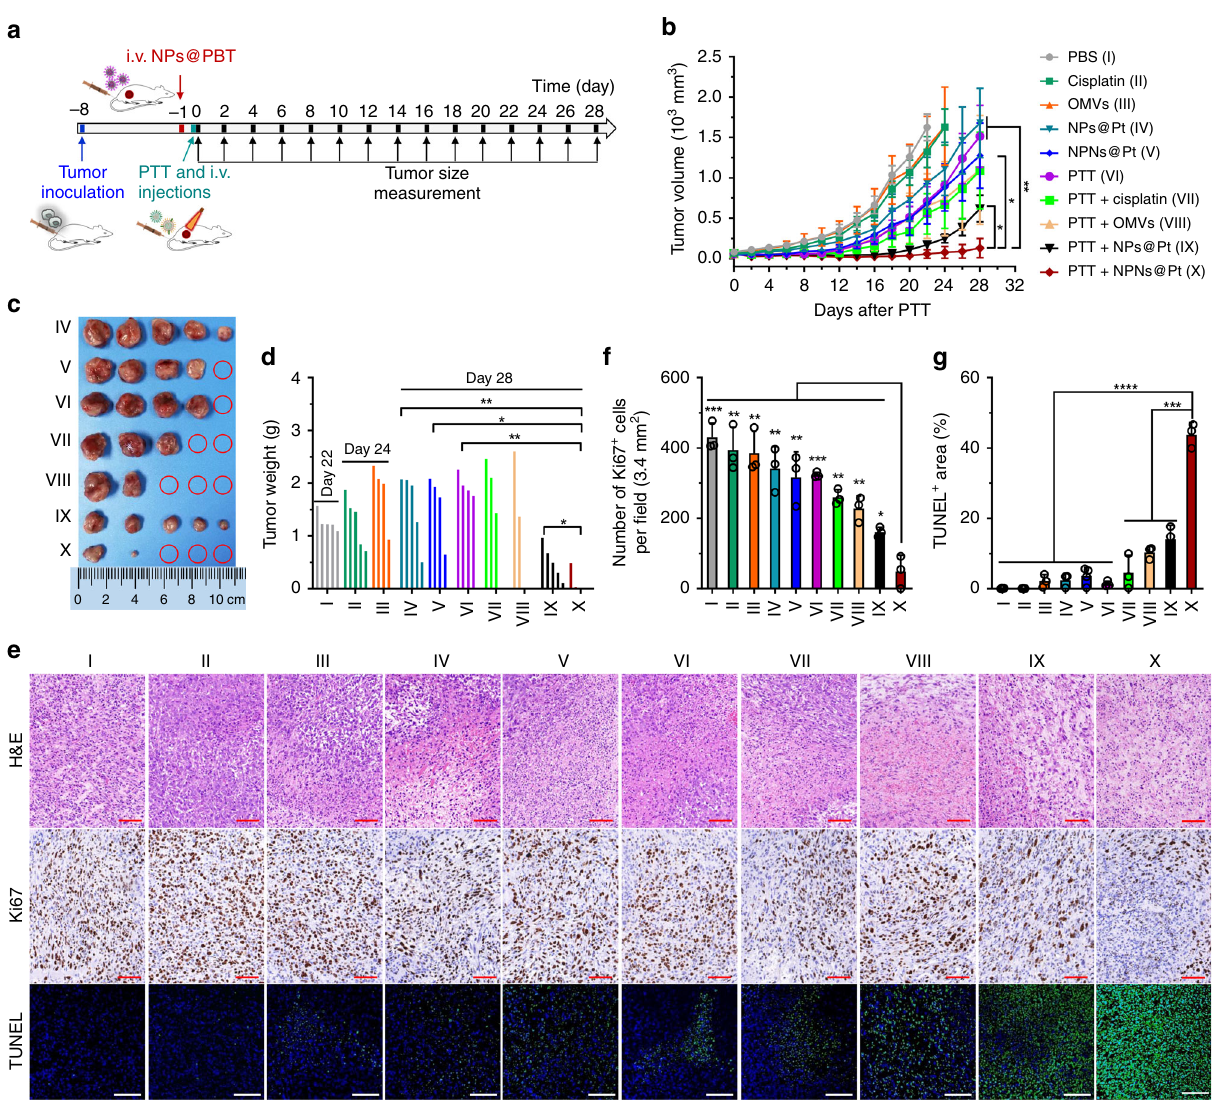
Fig. 7 PTT in combination with NPNs@Pt enhanced anti-tumor effect. a Work fl ow for treatment of EMT6-bearing mice using PTT-based neutrophil- mediated NPNs@Pt delivery system. On day -1 (de fi ned as the 7th day after tumor inoculation), mice were i.v . injected with NPs@PBT. On day 0, the mice were received PTT treatment and were administrated with PBS, cisplatin, OMVs, NPs@Pt, or NPNs@Pt after 30 min. Tumor volumes were measured every two days from day 0 to day 28. b Tumor growth curves during the treatments. c Photos and d weight of the tumors collected on day 28. n = 5 mice per group for b – d . e Representative images of H&E, Ki67, and TUNEL staining of tumor tissues obtained on day 3 after the PTT treatment. Scale bars, 100 μ m. f Number of Ki67 + cells per fi eld (3.4 mm 2 ) in the tumor slices in e . Signi fi cant analyses were performed compared with Group X. n = 3 per group. g Percentage of TUNEL + area in the tumor slices in panel e . n = 4 for group I, II, V, and n = 3 for all other groups. Data are shown as mean ± SEM ( b ) or mean ± SD ( f , g ), and analyzed by unpaired two-tailed Student ’ s t -test. * P < 0.05, ** P < 0.01, *** P < 0.001, **** P < 0.0001. Source data are provided as a Source Data fi